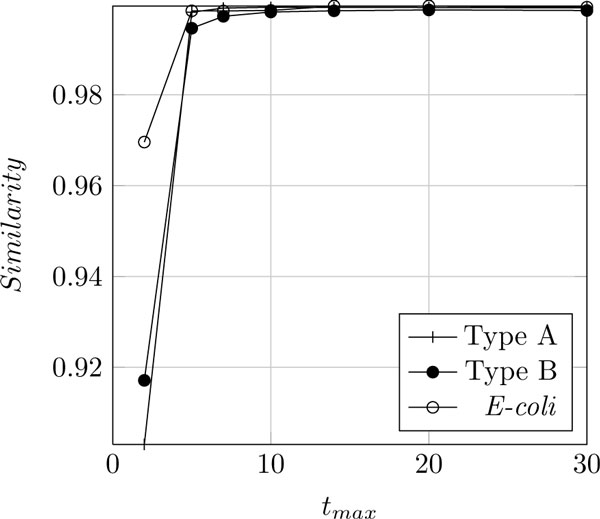
Similarity of y and ỹ  versus tmax